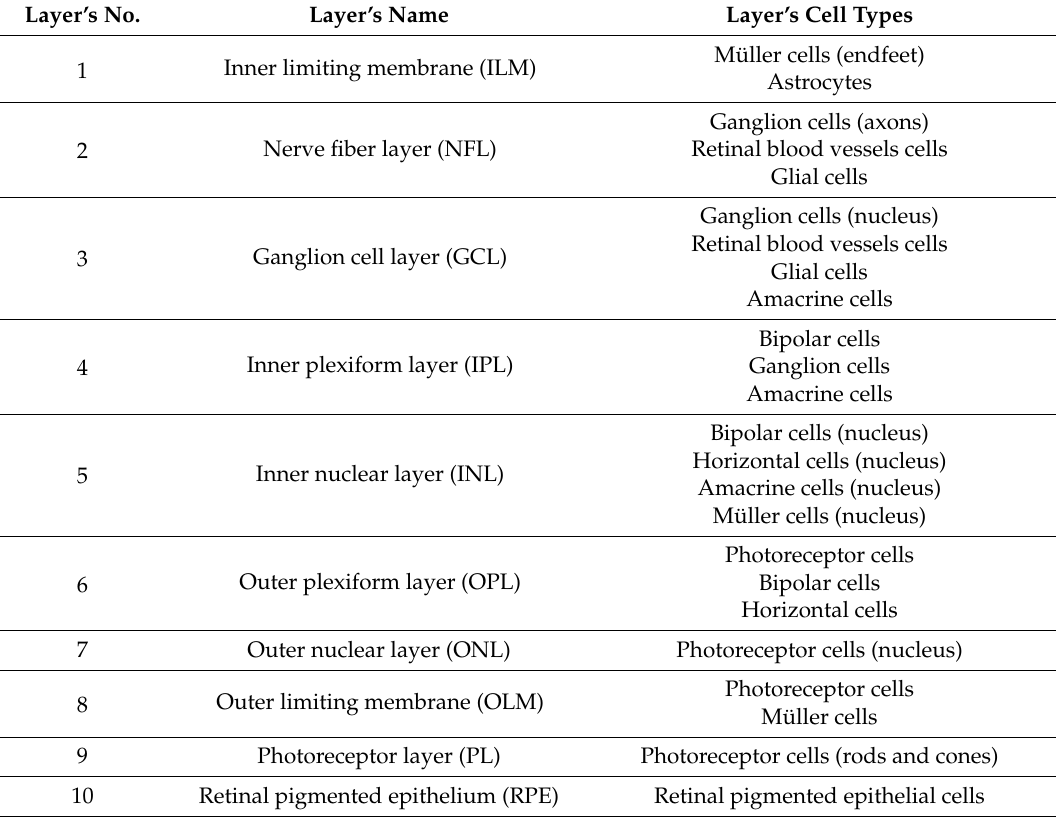
Table 1. Histological layers of the